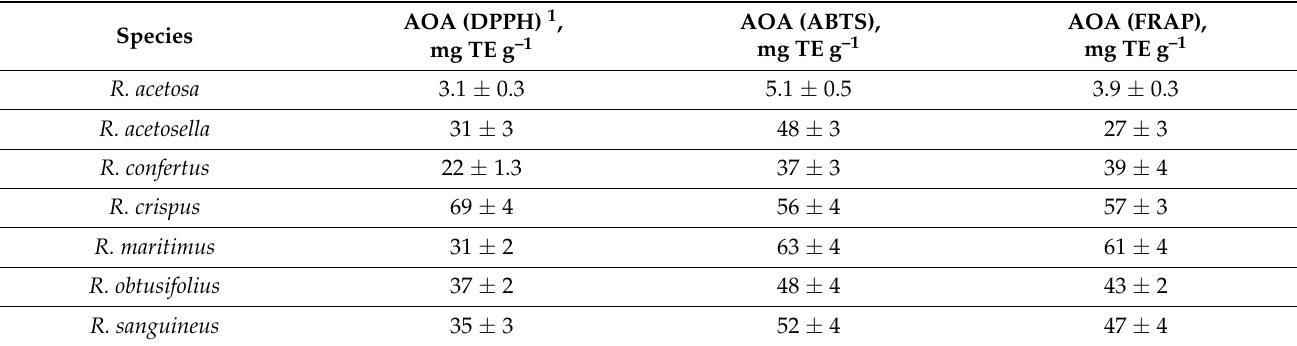
Table 3. Antioxidant activity of extracts from the leaves of different Rumex